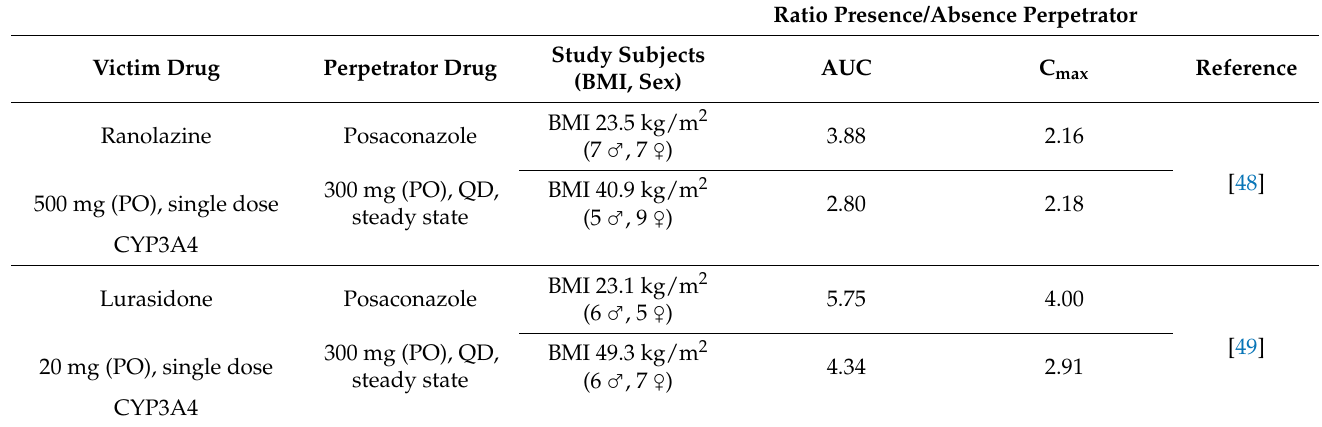
Table 5. Comparison of DDI magnitudes with inhibitors impacting drug metabolism in obese individuals relative to lean individuals.